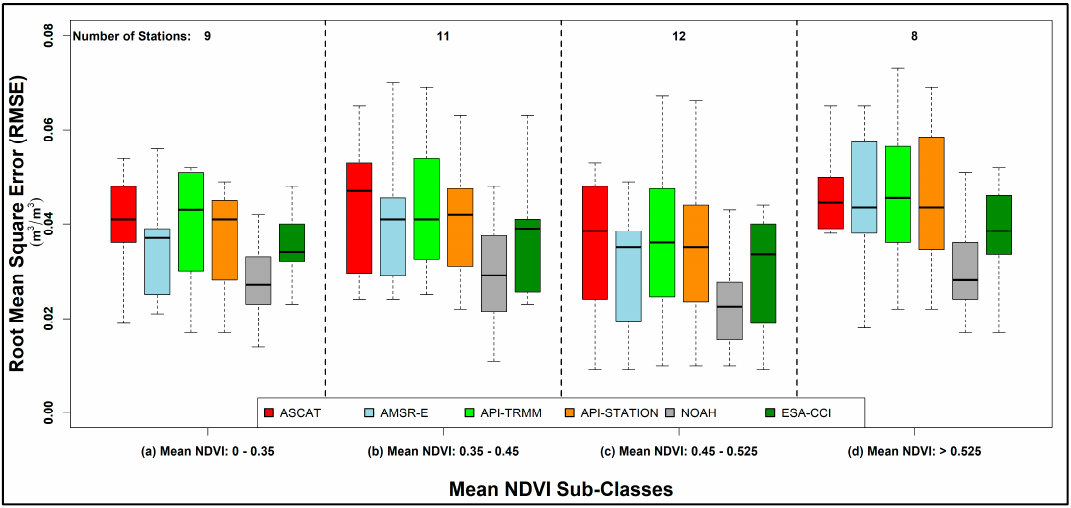
Figure 15. RMSE of soil moisture products under mean NDVI sub-classes